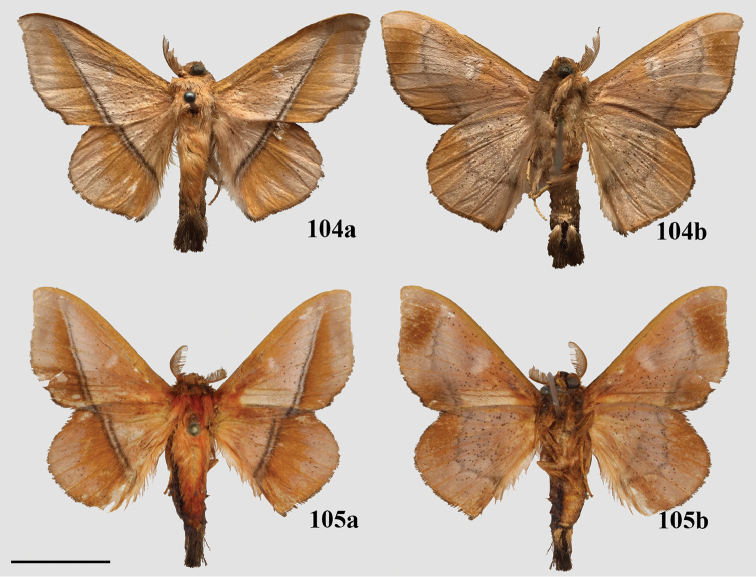
Adult male specimens of Fatellallafatellaa dorsal b ventral. 104 Holotype, French Guiana, St. Jean du Maroni (USNM) 105 French Guiana, Piste de Quesnel, km 7 [photo A Giusti] (NHMUK). Scale bar: 1 cm.